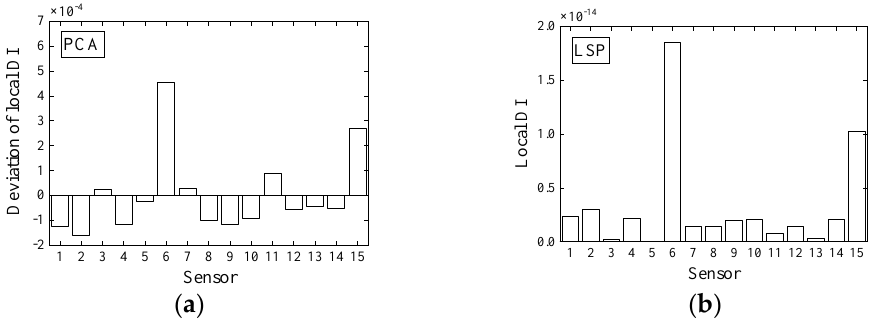
Figure 17. Results of local damage detection for a data missing case referred to in Figure 12. The WPES-based ( a ) PCA and ( b ) LSP methods are demonstrated, respectively.